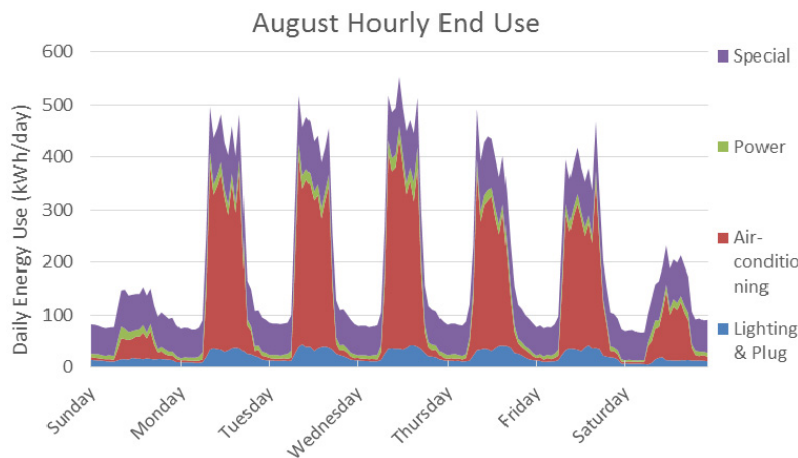
Figure 7. Typical weekly electricity end use in